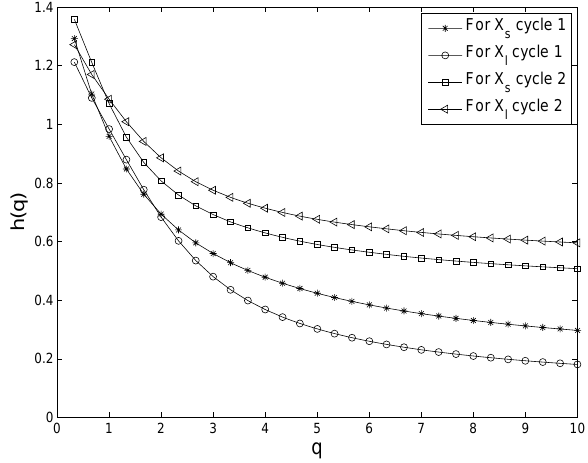
Fig. 5. The h(q) curves of the raw daily X l and X s data.